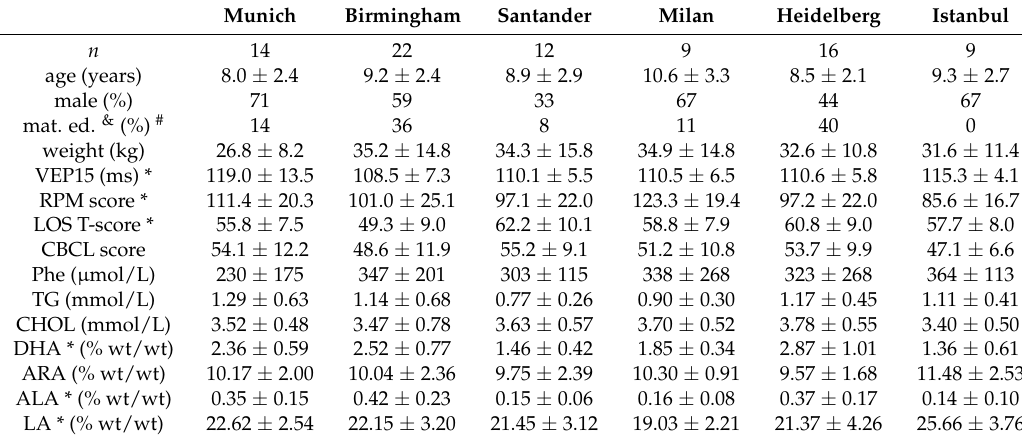
Table 1. Baseline description of the evaluated study participants in the individual study centres, data are given as mean ± SD or percentage.